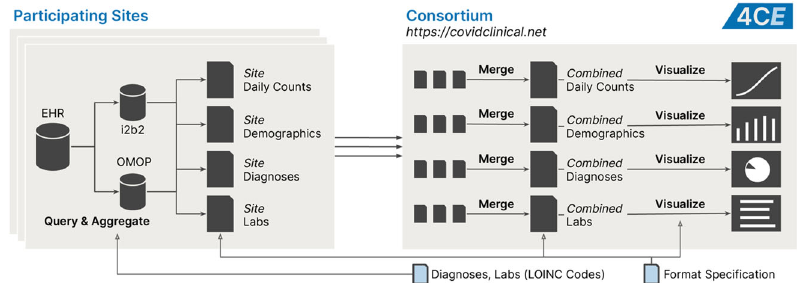
Fig. 6 Overview of data collection and